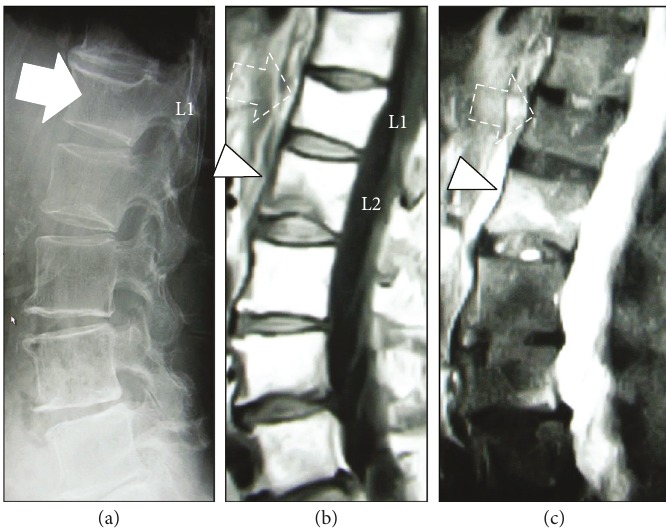
Figure 5: A 71-year-old woman with osteoporosis ( T -score < − 2.5 SD) and a history of no falls/injuries. (a) Plain lumbar radiography showed apossibleL1fracture(solidarrow).(b)T1-weightedMRIshowedacompressionfractureatthecaudaladjacentL2vertebralbody(arrowheads) with a high intensity change in the T2-STIR image (c) not at the presumed level (dotted arrow) (c).